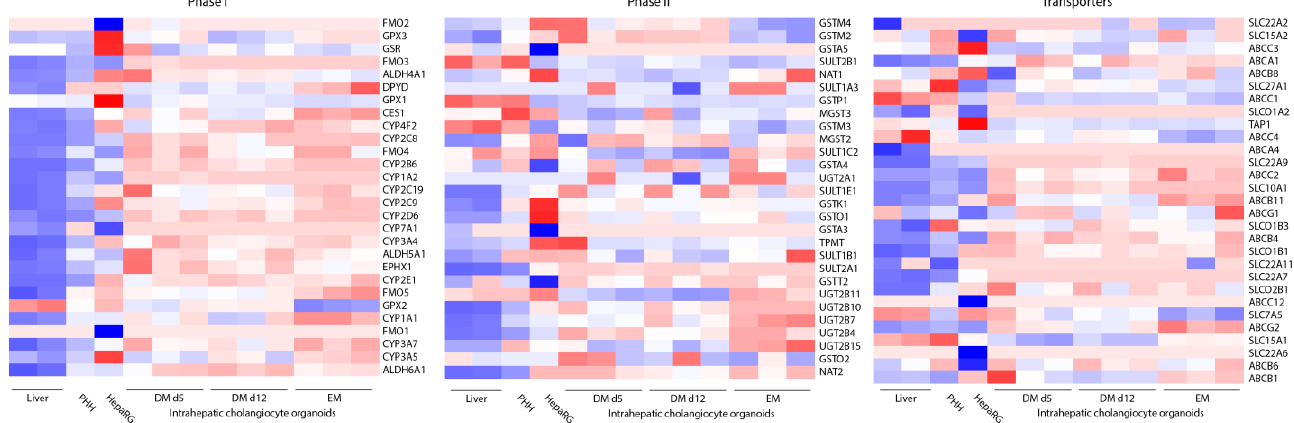
Figure 2. Heatmap showing the mRNA expression of intrahepatic cholangiocyte organoids from three independent donors in expansion (EM) and after hepatocyte differentiation (DM day 5 and day 12) compared with that of liver tissue, primary human hepatocytes (PHHs) and HepaRGs involved in drug metabolism (phase I ( n = 28), phase II ( n = 28), and transport ( n = 29)). Red indicates low expression. Blue indicates high expression.